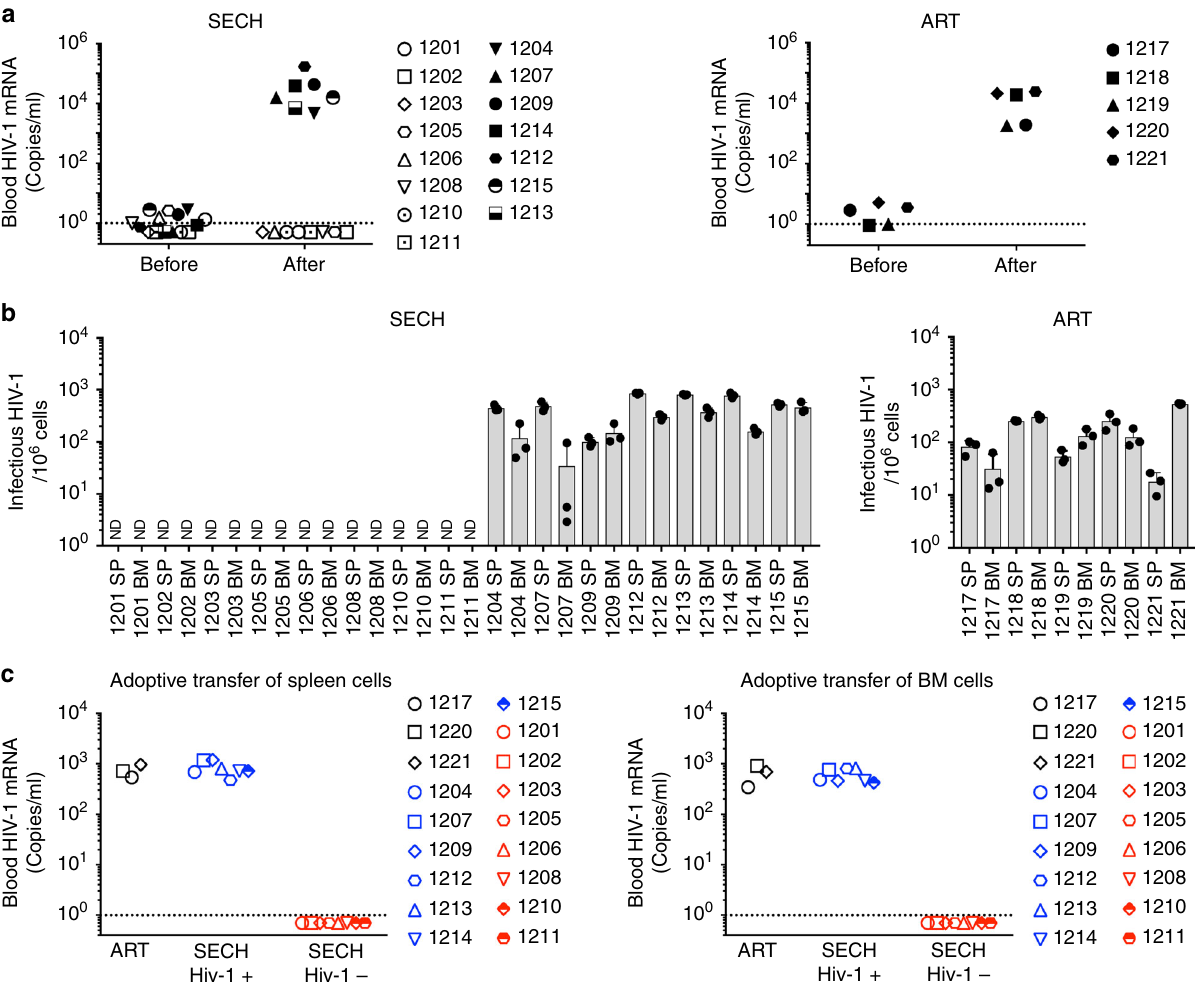
Fig. 4 Clearance of HIV-1 infections in Hu-HSC mice by SECH. a HIV-1 viral RNA levels in the blood of SECH- or ART-treated Hu-HSC mice before and after 2 months of withdrawal of the treatments (ART, n = 5; SECH, n = 15). The dash line indicates detection limit. b Measuring infectious HIV-1 from spleen and bone marrow (BM) cells of HIV-1-infected Hu-HSC mice by TZA. Data are presented as mean ± SD (ART, n = 5 mice; SECH, n = 15 mice). Data are presented as mean ± SD. Each biological sample was measured in three technical replicates. ND, not detectable. c Virus outgrowth assay after adoptive transfer of spleen and BM cells from mice as in c into uninfected Hu-HSC recipient mice. (ART, n = 3 mice; SECH, n = 15 mice). Source data are provided as a Source Data fi